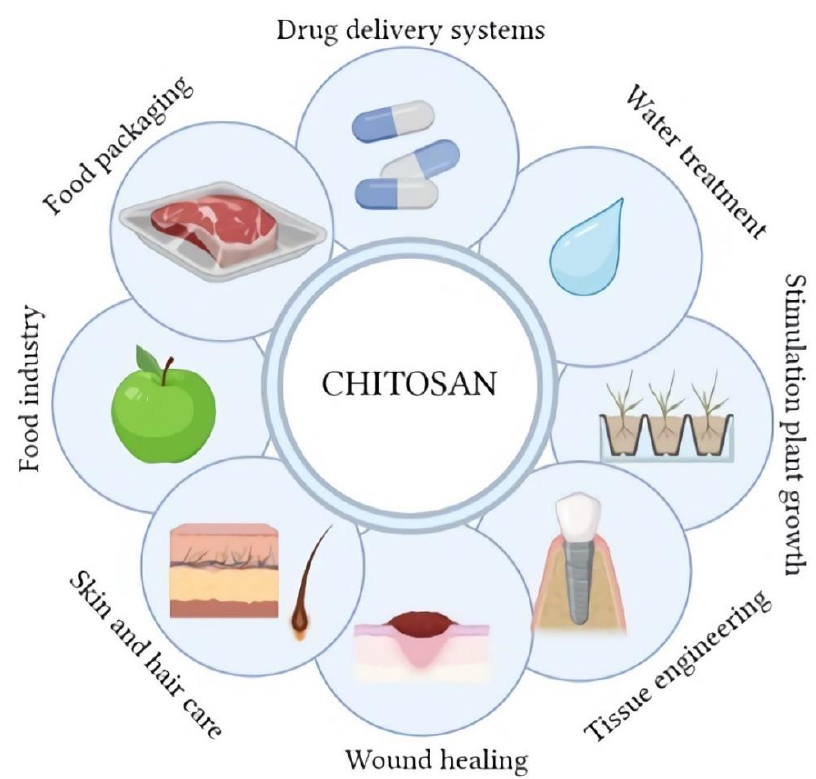
Figure 4. The main applications of chitosan (Created with BioRender.com; accessed on 4 January 2023).